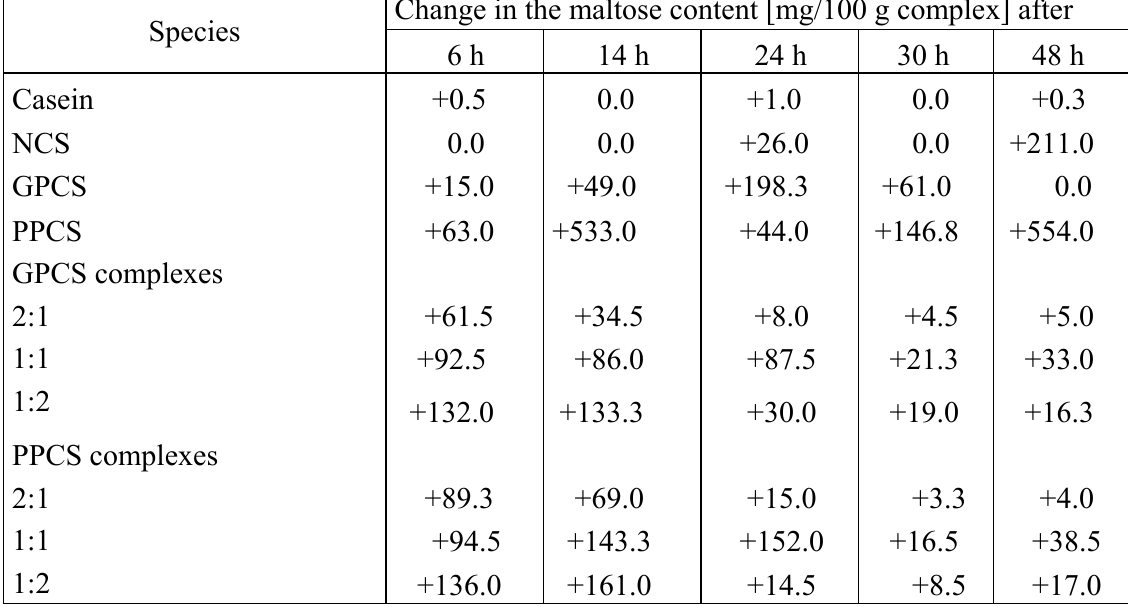
Biodegradability of native corn (NCS), waxy corn (NWCS), phosphated granular corn (GPCS) and pasted corn (PPCS), granular waxy corn (GPWCS) and pasted waxy corn (PPWCS) starches and their complexes with casein Change in the maltose content [mg/100 g complex] after